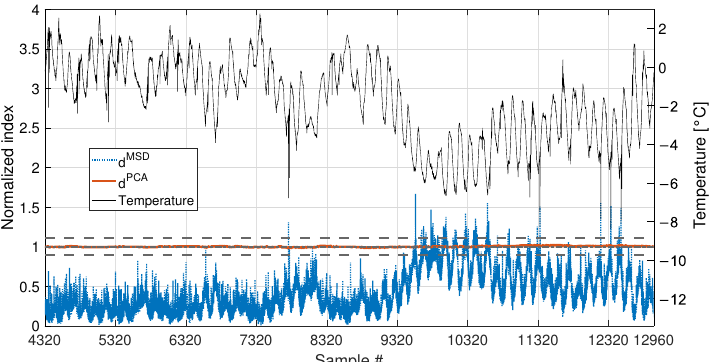
Figure 19. Comparison between d MSD (blue dotted line) and d PCA (red solid line), with b = 4320, in case of a real temperature trend (black thin line).